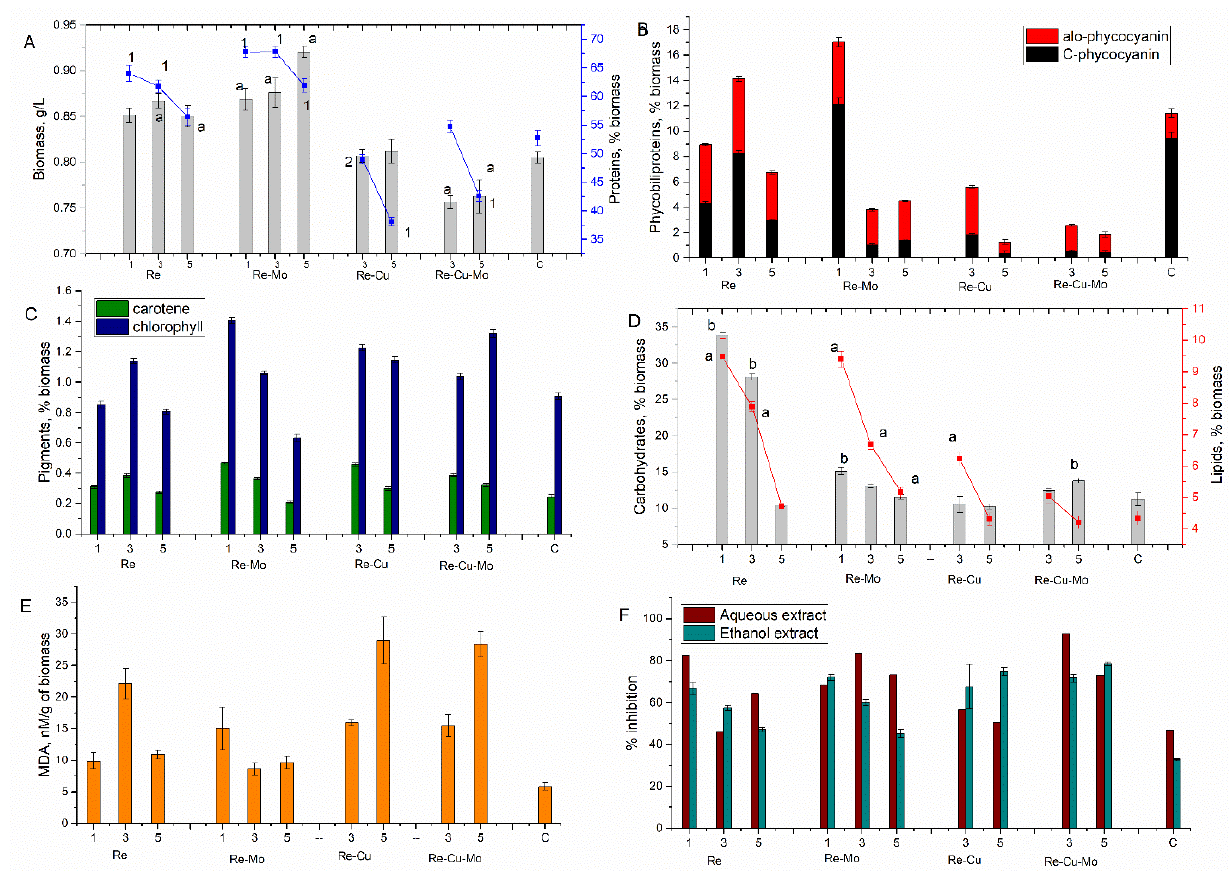
Figure 2. ( A ). Biomass and protein content in Spirulina biomass grown in media supplemented with metals (a— p < 0.005 for differences in biomass between control and experiment; 1— p < 0.001 for differences in protein content between control and experiment; 2— p < 0.01 for differences in protein content between control and experiment); ( B ) change in the content of phycobiliproteins in Spirulina biomass grown in media supplemented with metals ( p < 0.005 for differences between control and experiment); ( C ) changes in pigment content in Spirulina biomass grown in media supplemented with metals ( p < 0.005 for differences between control and experiment, for all parameters, except for the case of carotene in Re-Mo system at stationary stage); ( D ) changes in the content of carbohydrates and lipids in the biomass of Spirulina grown in media supplemented with metals (a— p < 0.005 for differences in lipid content between control and experiment; b— p < 0.005 for differences in the content of carbohydrates between control and experiment); ( E ) changes in the content of MDA in the biomass of Spirulina grown in media supplemented with metals; ( F ) modification of the antioxidant activity of Spirulina extracts grown in media supplemented with metals ( p < 0.01 for differences between control and experiment, for all parameters, except for the case of aqueous extract in Re system at exponential phase and Re-Cu system at stationary phase), (cultivation days 1, 3, 5, when metal ions were introduced into the cultivation medium; biomass was determined on the sixth day of cultivation).